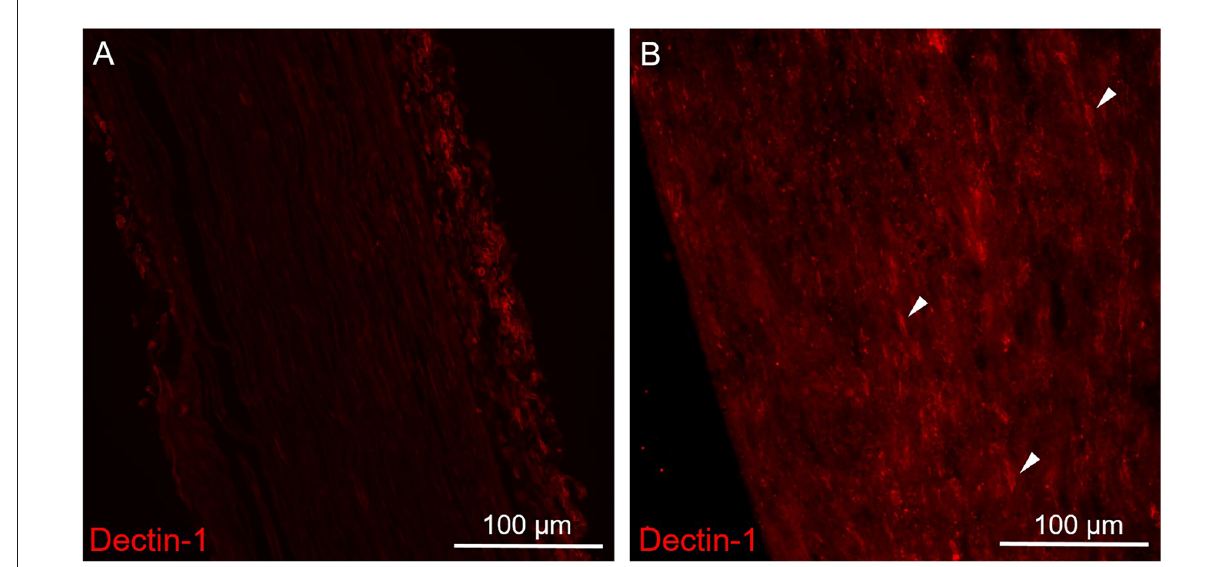
FIGURE2 Immunofluorescence staining of Dectin-1 on the control (contralateral) and crushing injury (ipsilateral) side of the sciatic nerves. Longitudinal sections from mice sciatic nerve 7 days after surgery of the control (contralateral) side (A) and the side of crushing injury (ipsilateral) (B) were stained with anti-Dectin-1 primary antibody (Cy3). (A) There was no Dectin-1 expression on the control side. (B) After crushing injury, there was presence of cigarette-shaped positive staining areas mimicking the morphology of macrophage on the ipsilateral sciatic nerve